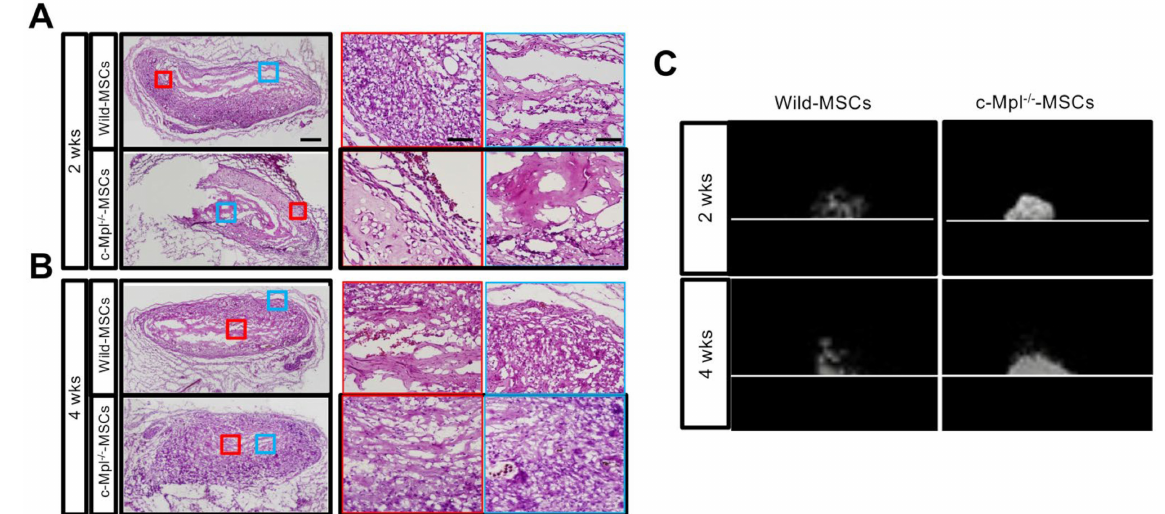
Figure 5. c-Mpl deficiency correlated with the differentiation ability of MSCs. ( A , B ) Hematoxylin and eosin staining shows ectopic bone formation at 2 weeks ( A ) and 4 weeks ( B ) after transplantation (left panel: low magnification; right panel: high magnification) ( n = 3). Representative data are presented. ( C ) µ CT findings of ectopic bone at 2 and 4 weeks after transplantation. At two weeks after transplantation, a high-intensity signal was detected in the group with c-Mpl-deficient MSCs ( n = 3). Representative data are